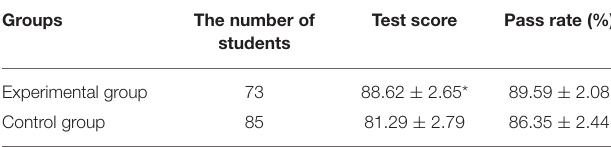
TABLE 2 | The average score of theory examination. Groups The number of Test score Pass rate (%) students Experimental group 73 Control group * p < 0.05 vs. Control